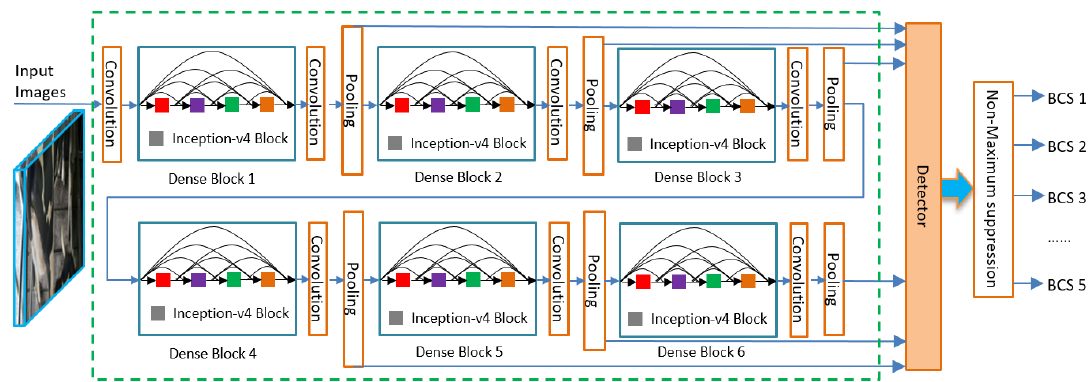
Figure 6. The improved SSD model used for BCS assessing.